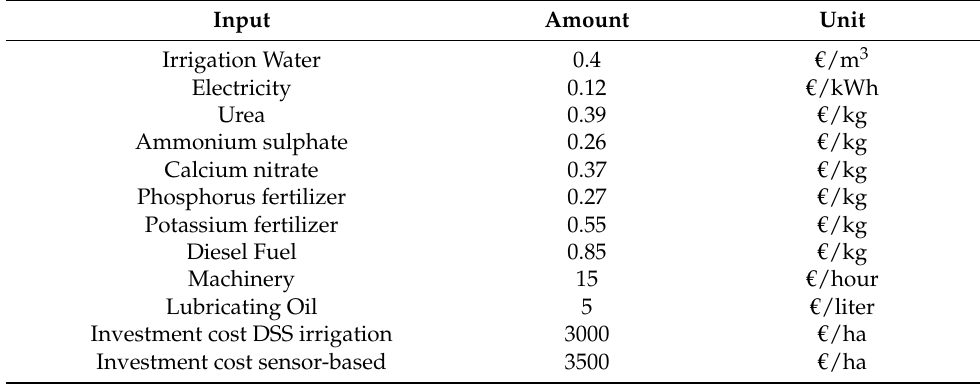
Table 2. Input data used in cost